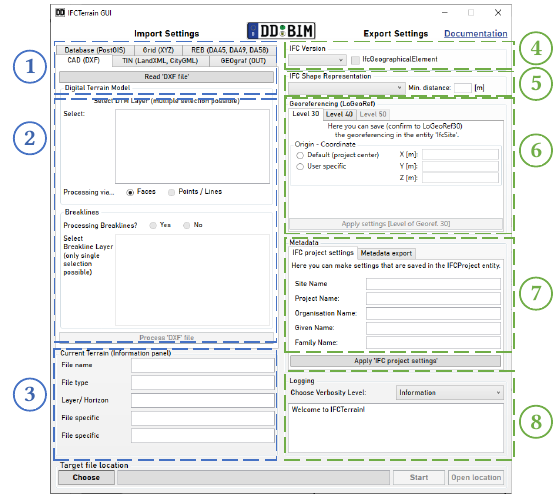
Figure 6. IfcTerrain GUI for simple but